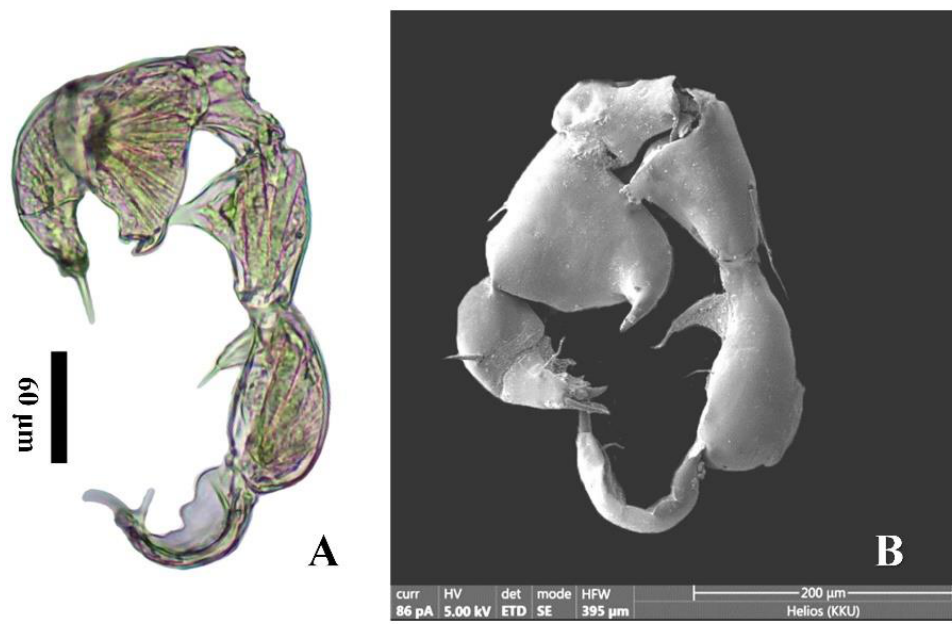
Figure 3. Photographs of the male leg 5 (P5) of a brackish-water calanoid copepod, Acartiella sinensis : pictures taken using a light microscope ( A ) and a scanning electron microscope ( B ).